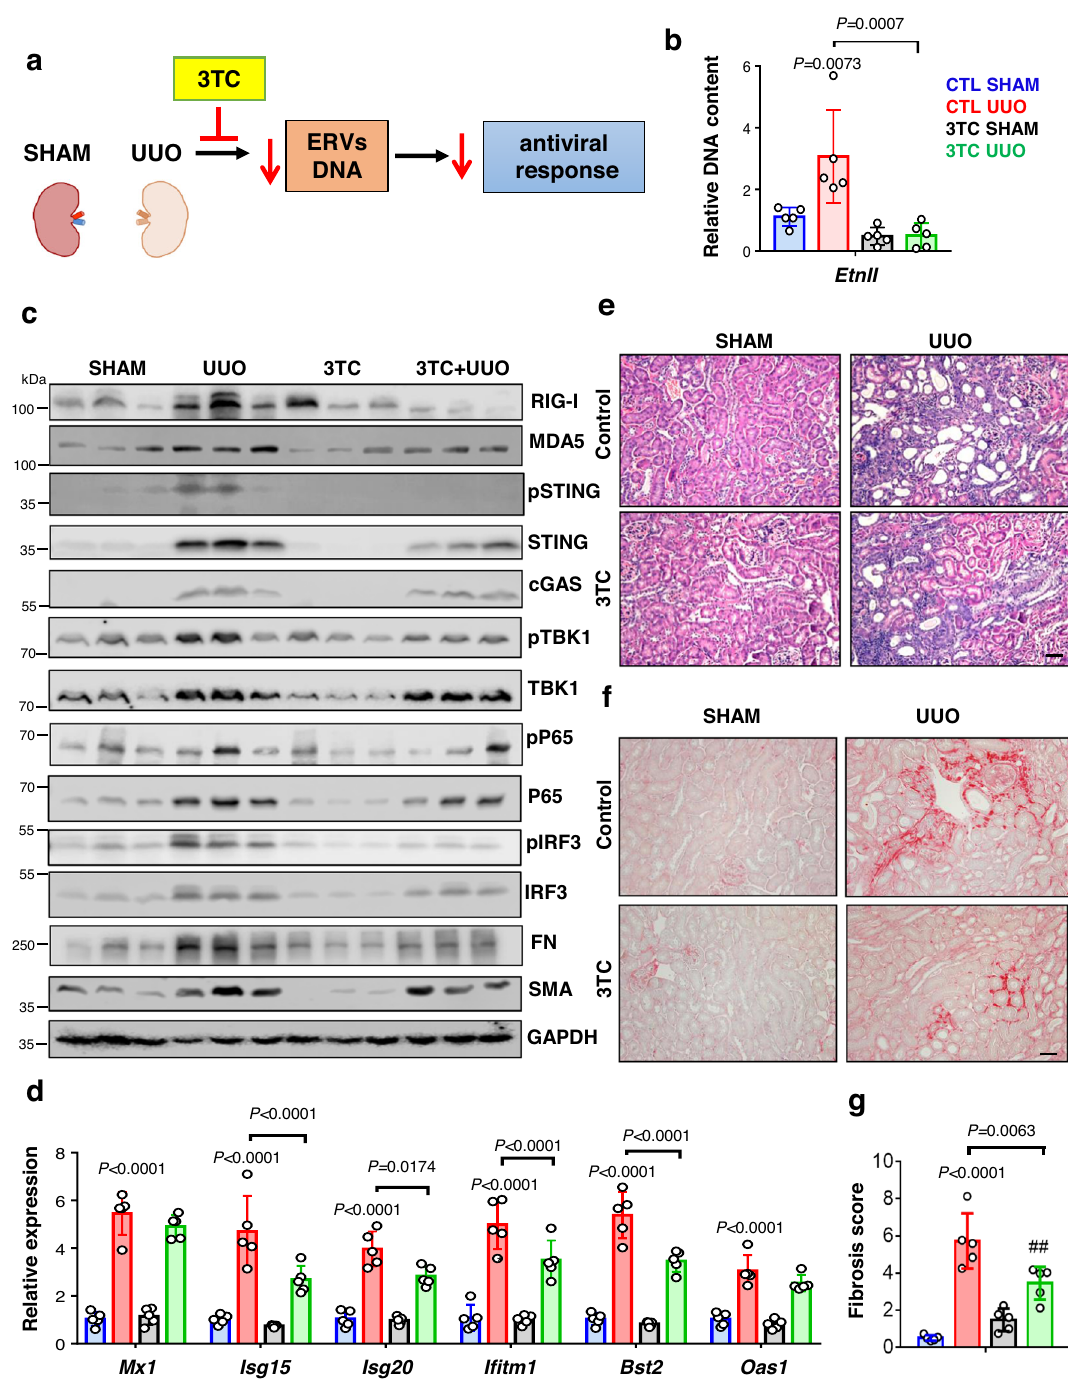
Fig. 10 | The reverse transcriptase inhibitor Lamivudine ameliorates fi broin- fl ammation.a Experimentalscheme. b RelativeDNAcontentofEtniiinkidneysof mice underwent sham or UUO surgery and injected with vehicle or 3TC (CTL SHAM, blue; CTL UUO, red; 3TC SHAM, black; 3TC UUO, green; n =5 in each). c Representative images of Western blots of RIG-I, MDA5, cGAS, pSTING, STING, pTBK1, TBK1, pP65, P65, pIRF3, IRF3, FN, and SMA protein levels in kidneys of sham and UUO mice injected with vehicle or 3TC. GAPDH was used as a loading control. d Relative mRNA levels of ISGs ( Mx1, Isg15, I fi tm1, Bst2 , and Oas1 ) in kid- neys of SHAM and UUO mice injected with vehicle or 3TC ( n =5 in each). e Representative hematoxylin andeosin(H&E)staining ofkidneys from sham and